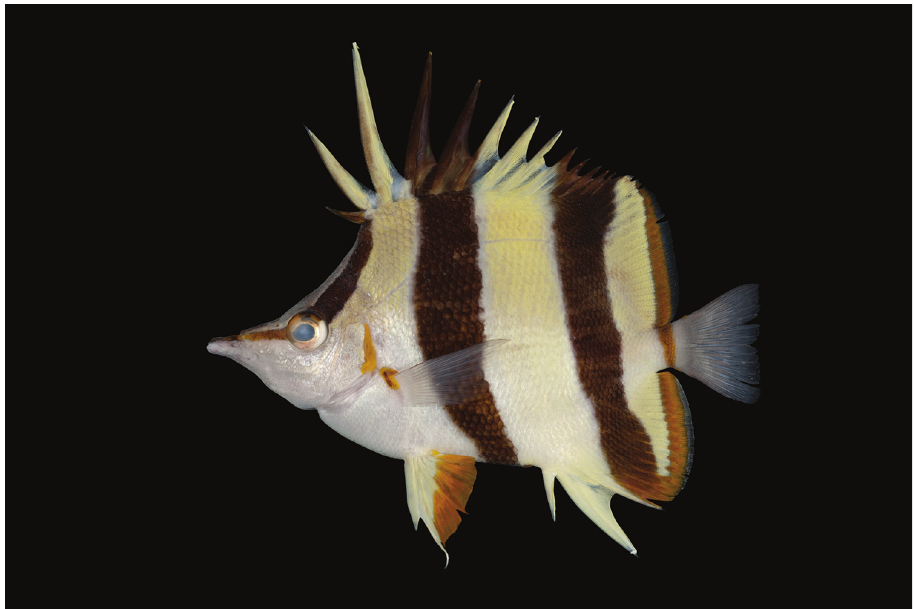
Figure 2. Paratype of Prognathodes basabei (BPBM 41285-1), collected at a depth of 55 m off Pearl and Hermes Atoll, Northwestern Hawaiian Islands. Photo by R. L.